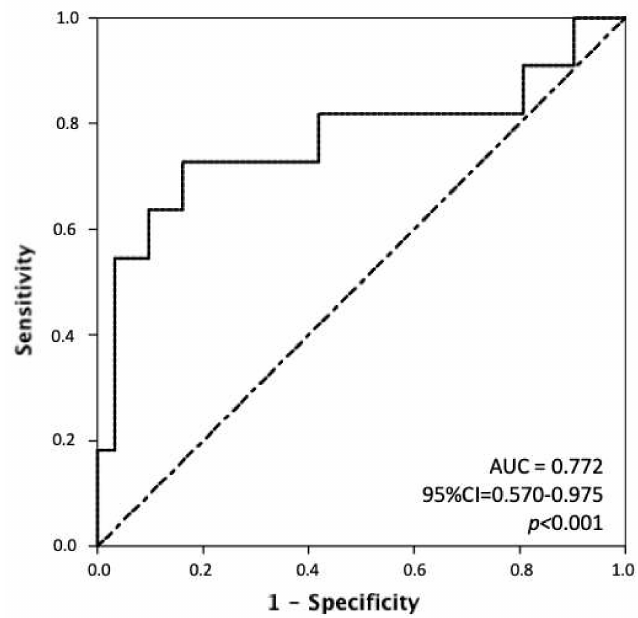
Figure 2. The figure shows the Receiver Operating Characteristics (ROC) curve analysis of metabolic tumor volume (MTV) for the prediction of overall survival. With an area under the curve (AUC) = 0.77 (95%CI = 0.57–0.97; p < 0.001), we found that 380 mL was the best cutoff value (sensitivity = 82%, specificity = 62%) for the discrimination of overall survival after hepatectomy for HCC.